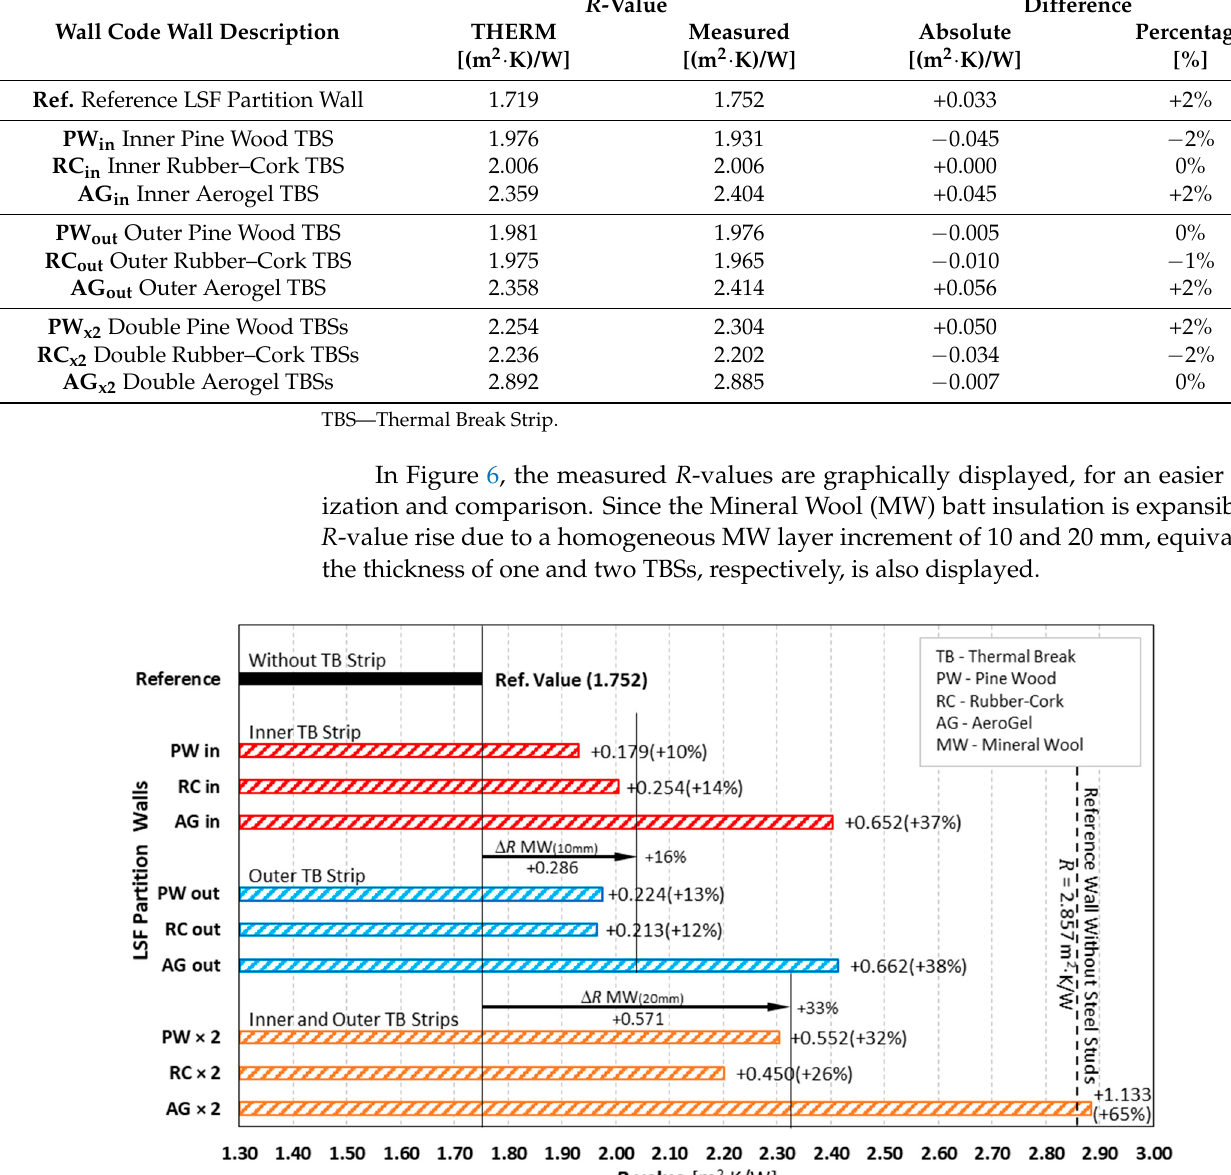
Cork (RC) composite (0.088 W/m·K) and Pine Wood (PW) (0.130 W/m·K), being higher in relation to Aerogel (AG) (0.015 W/m·K)). So, as expected, when using TBS materials with